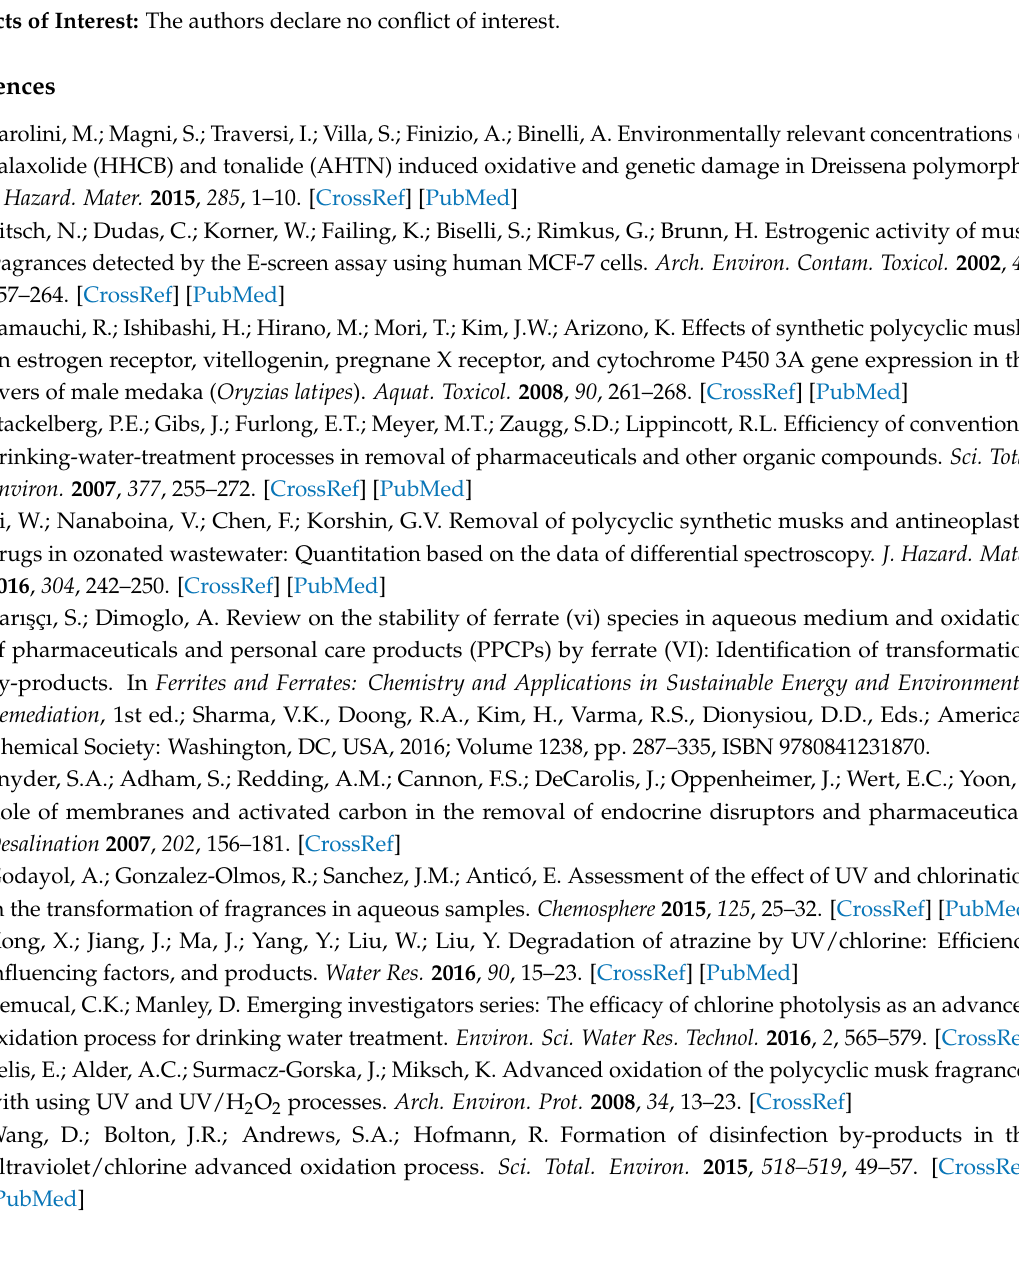
Section S1: Determination of effective optical path length. Section S2: Determination of k(HO • + AHTN) and k(RCS + AHTN). Section S3: Determination of ε AHTN,254 and Φ AHTN,254 . Figure S1: Set-up and construction of photoreactor; Figure S2: Energy output profile of UV lamp. Figure S3: UV Photolysis of H 2 O 2 . Figure S4: Degradation of AHTN and NB by (a) PMS oxidation in presence of 10 µ M isopropanol and (b) direct UV photolysis. Figure S5: -ln ([AHTN]/[AHTN] 0 ) Vs -ln ([NB]/[NB] 0 ). Figure S6: k Figure S7: Degradation of AHTN and DMOB in the ClO • system. Figure S8: UV absorbance of AHTN at different concentration. Figure S9: Degradation of AHTN corresponding to different absorbed photon. Figure S10: Chromatogram for HPLC of AHTN degradation by (a) FC, (b) UV, and (c) UV/FC. Figure S11: AHTN degradation by UV/FC under various conditions. Table S1: Method detection limits (MDL) of halogenated